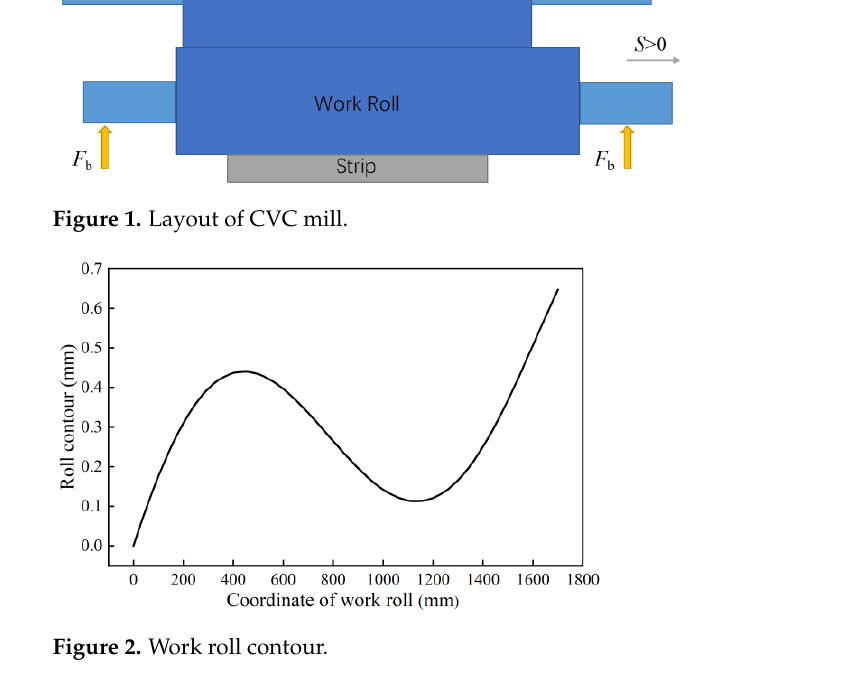
Figure 2. Work roll contour.